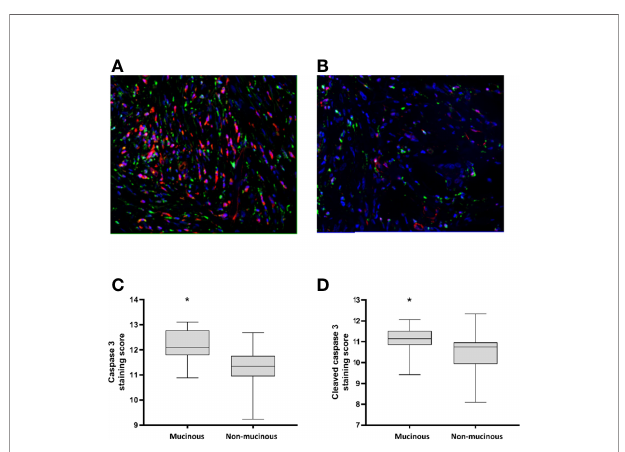
FIGURE 1 | Caspase protein levels in mucinous versus non-mucinous colorectal cancer. (A) Mucinous rectal cancer tumor core stained with pro- Caspase 3 (red), cleaved-Caspase 3 (green), DAPI (blue=nucleus); (B) Non- mucinous rectal cancer tumor core stained with pro-Caspase 3 (red), cleaved- Caspase 3 (green), DAPI (blue=nucleus); (C) Quanti fi cation of pro-Caspase 3 protein level in 14 mucinous and 39 non-mucinous rectal cancers, *=p<0.05. p value for t-test comparing mean protein level between mucinous and non- mucinous cancers; (D) Quanti fi cation of cleaved-Caspase 3 protein level in 14